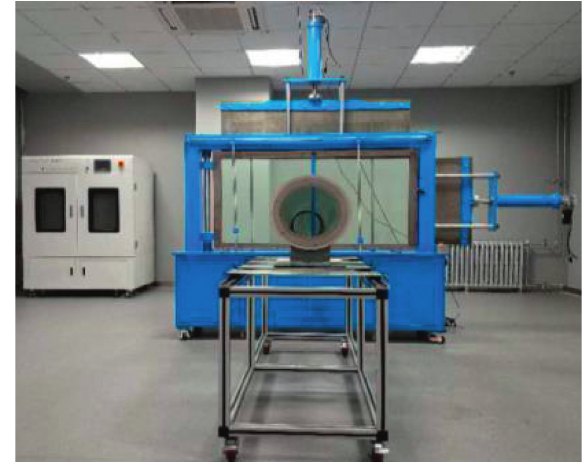
Figure 1: Biaxial photoelastic instrument for particulate matter.